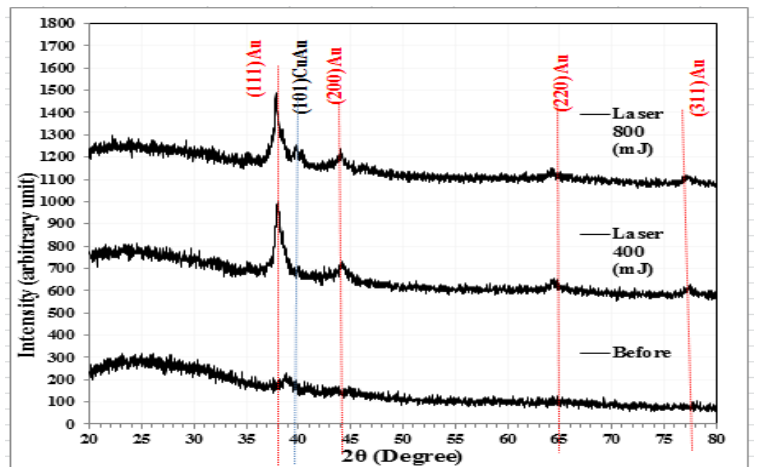
Fig. 5: X-ray diffraction pattern of A-alloy colloid NPs for exploding currents 75A and synthesized by (400 m J, 800 m J) laser energies Irradiation.